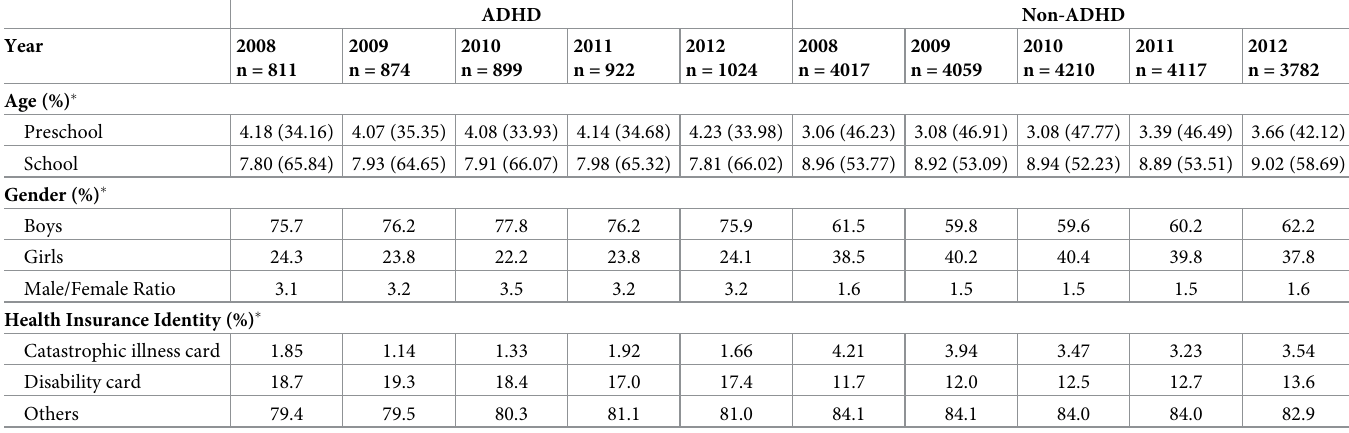
Table 1. Demographic characteristics of 3–12-year-old children receiving rehabilitation care.